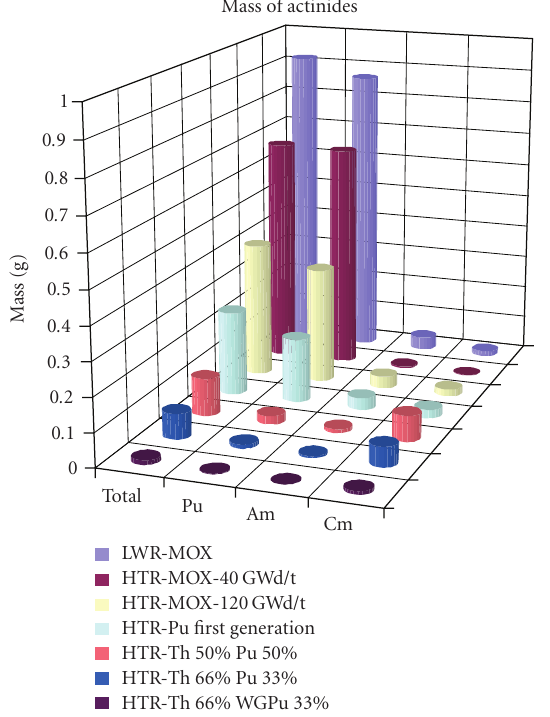
Figure 1: Mass of actinides at EOC starting from 1g of Pu [4].